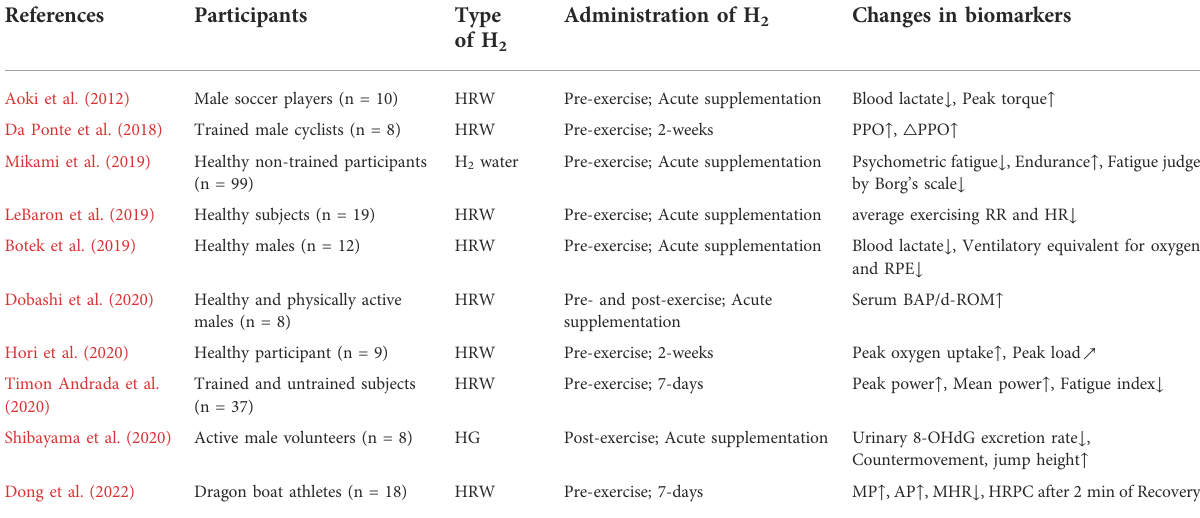
TABLE 1 Summary of anti-fatigue effects of H 2 in human clinical